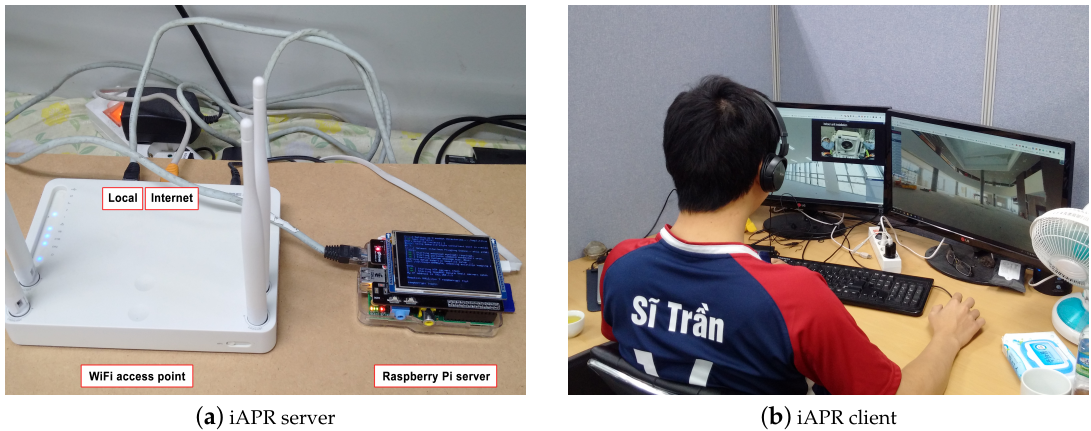
Figure 4. The iAPR system prototype